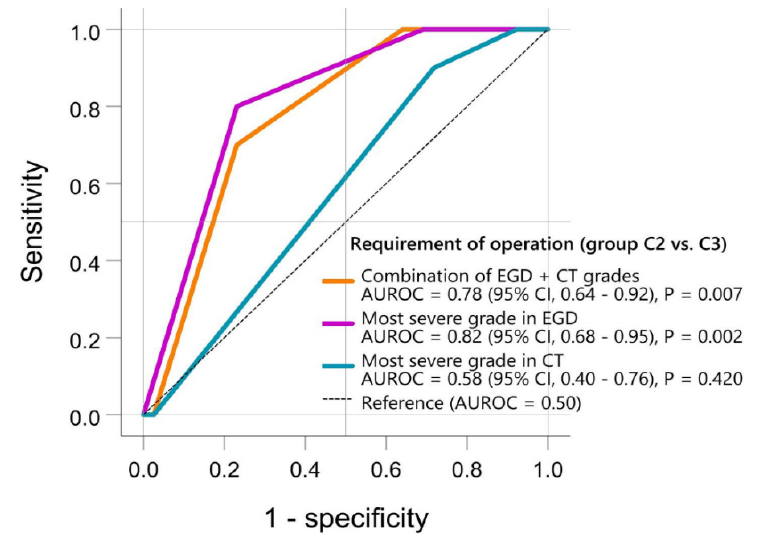
Figure 5. Grades of esophagogastroduodenoscopy (EGD) and computed tomography (CT) in differentiating group C2 (requiring operation) and group C3 (not requiring operation). The “most severe EGD/CT grades” refers to the most severe grade among the esophagus, stomach, and duodenum in each patient under EGD (Zargar’s 0, 1, 2a, 2b, 3a, 3b) and CT (grades 1, 2, 3, 4), respectively. The “combination of EGD + CT grades” is calculated by EGD (Zargar’s 0, 0 point; Zargar’s 1, 1 point; Zargar’s 2a, 2 points; Zargar’s 2b, 3 points; Zargar’s 3a, 4 points; Zargar’s 3b, 5 points) plus CT (grade 1, 1 point; grade 2, 2 points; grade 3, 3 points; grade 4, 4 points). Hence, the “combination of EGD + CT grades” ranges from 1 to 9 points. Abbreviations: AUROC, area under the receiver operating characteristic curve; CI, confidence interval; CT, computed tomography; EGD, esophagogastroduodenoscopy.